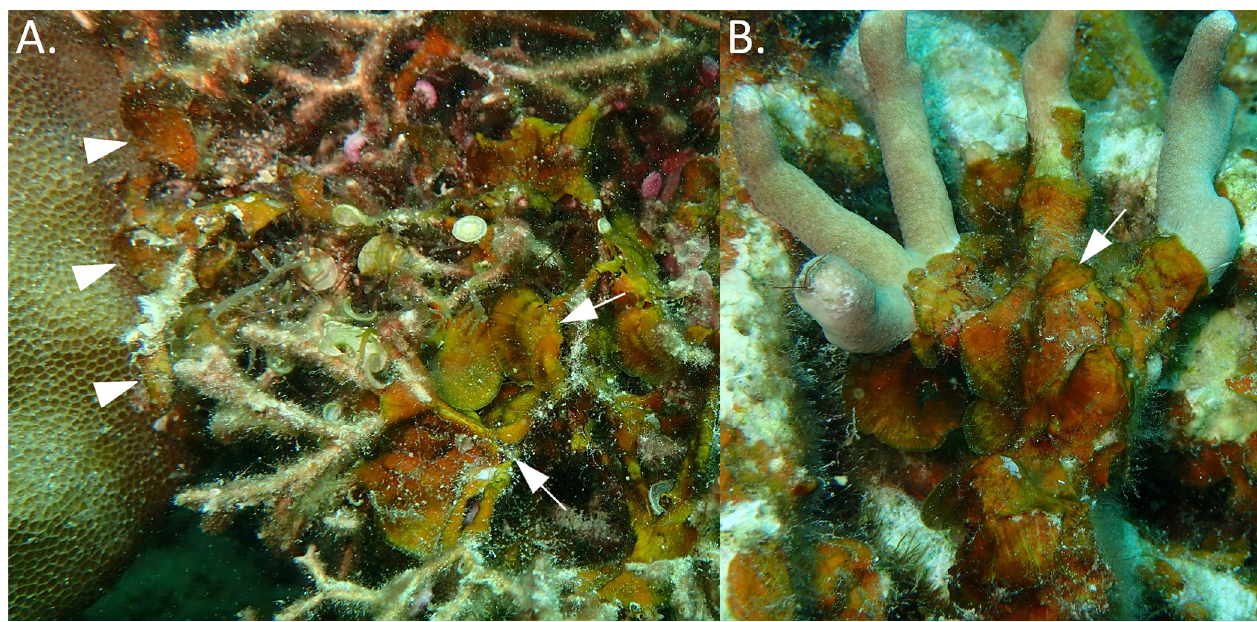
Fig 7. Coral overgrowth by Lobophora sp28. A) Example showing Lobophora sp28 growing on Galaxaura divaricata (arrows), and in contact with coral ( Porites solida ) (arrowheads). B) Coral overgrowth ( Porites cylindrica in this case) by Lobophora sp28 is widespread in the shallow lagoon of Dongsha